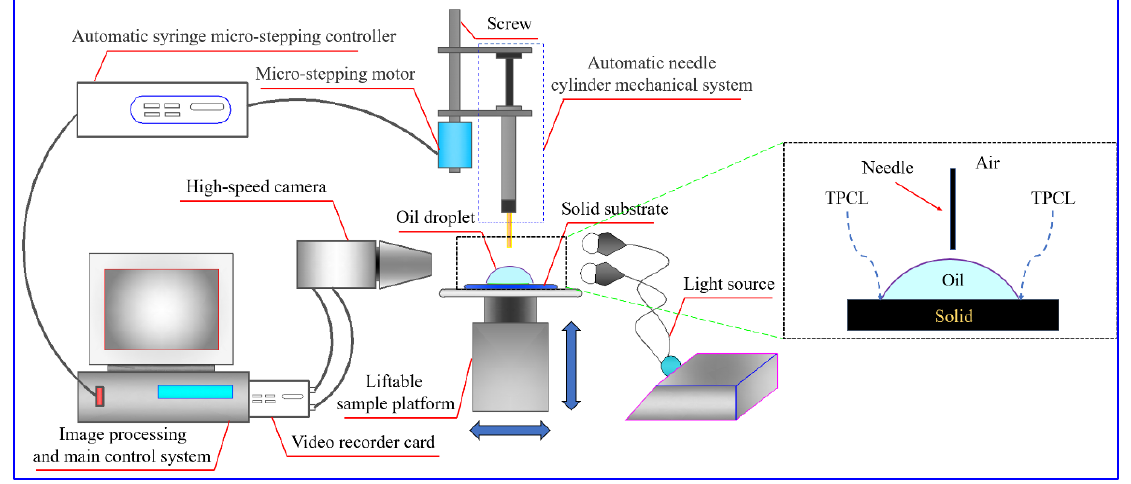
Figure 1. Schematic of the experimental setup for studying the spreading behavior of an oil droplet on the Teflon in air [42].